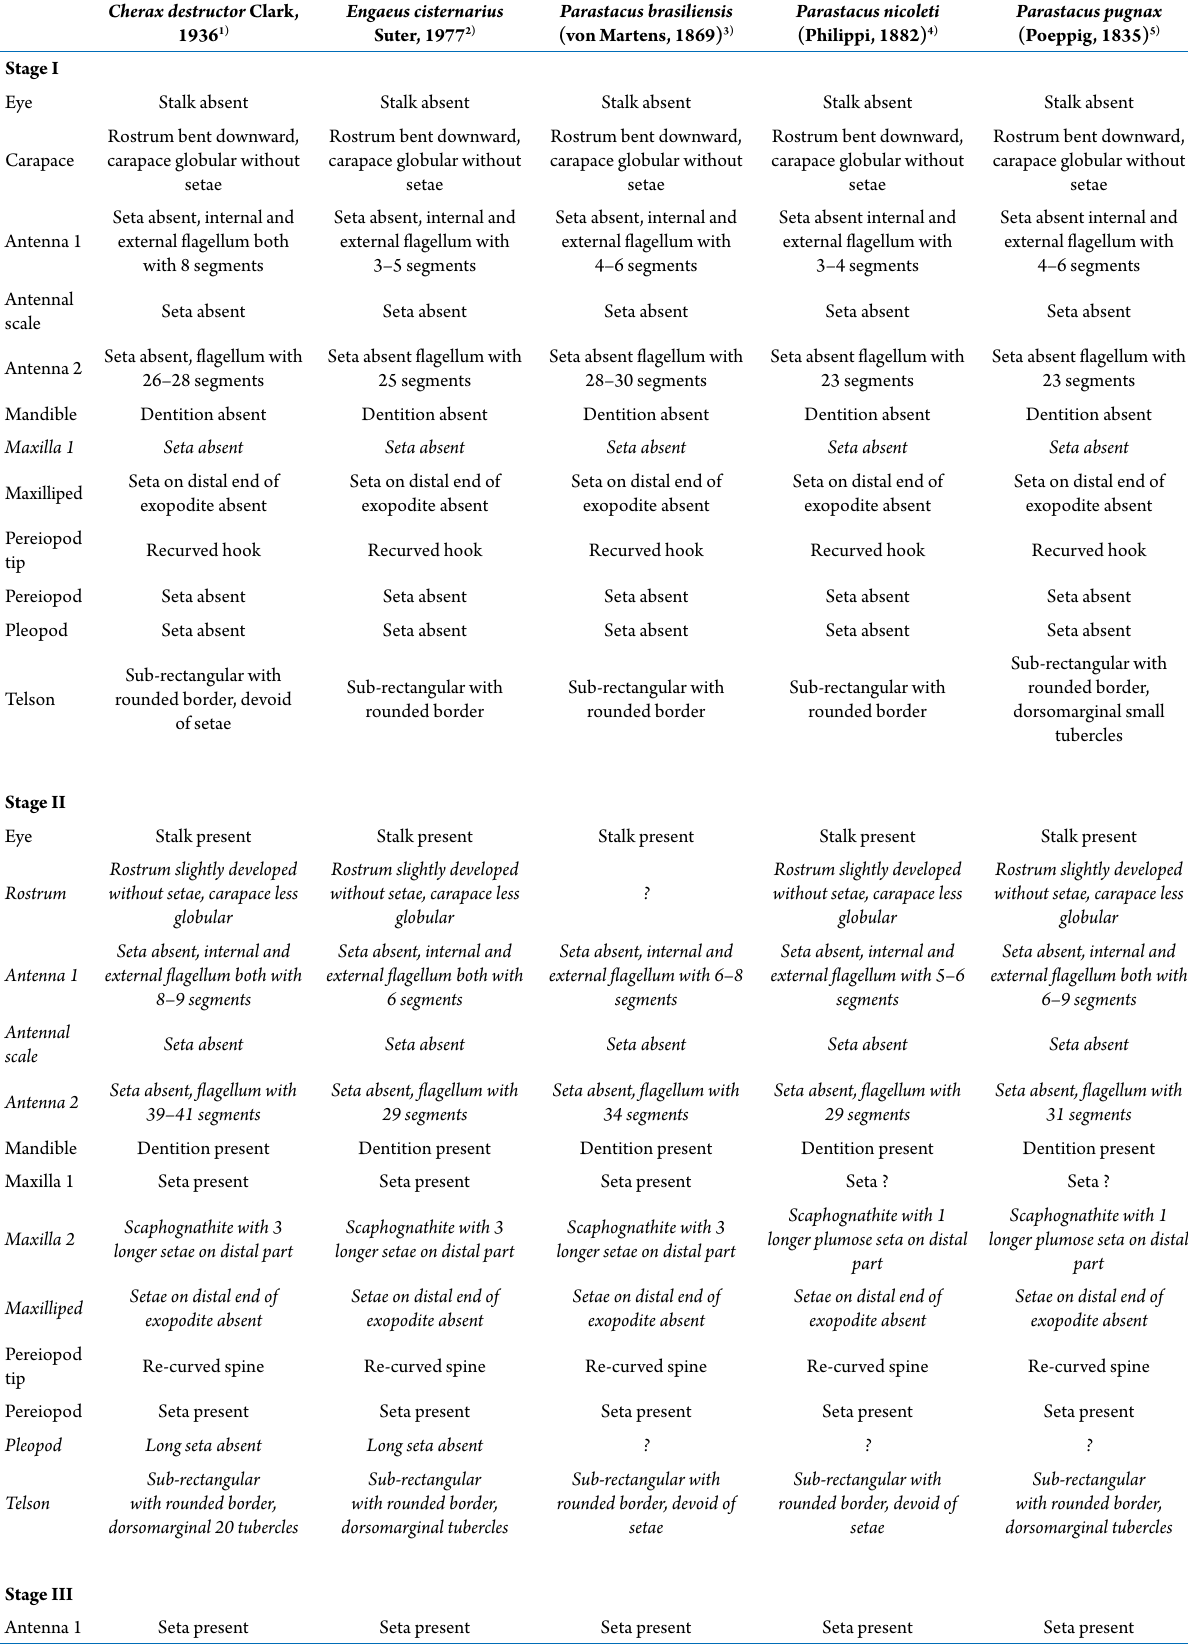
Table 4. Comparison of the morphology of each postembryonic stage of Parastacidae members. Cherax destructor Clark, 1936